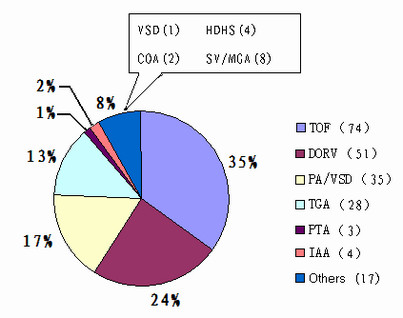
Distribution of phenotypes of cardiac anomalies in patients with CTDs in this study. Abbreviations: TOF: tetrology of Fallot; DORV: Double outlet of right ventricle; PA/VSD: pulmonary atresia/ventricular septal defect; TGA: transposition of the great arteries; PTA: persistent truncus arteriosus; IAA: interruption of aortic arch; VSD: ventricular septal defect; HDHS: hypoplastic right heart syndrome; COA: coarctation of aorta; SV/MGA: single ventricle/malposition of great arteries.